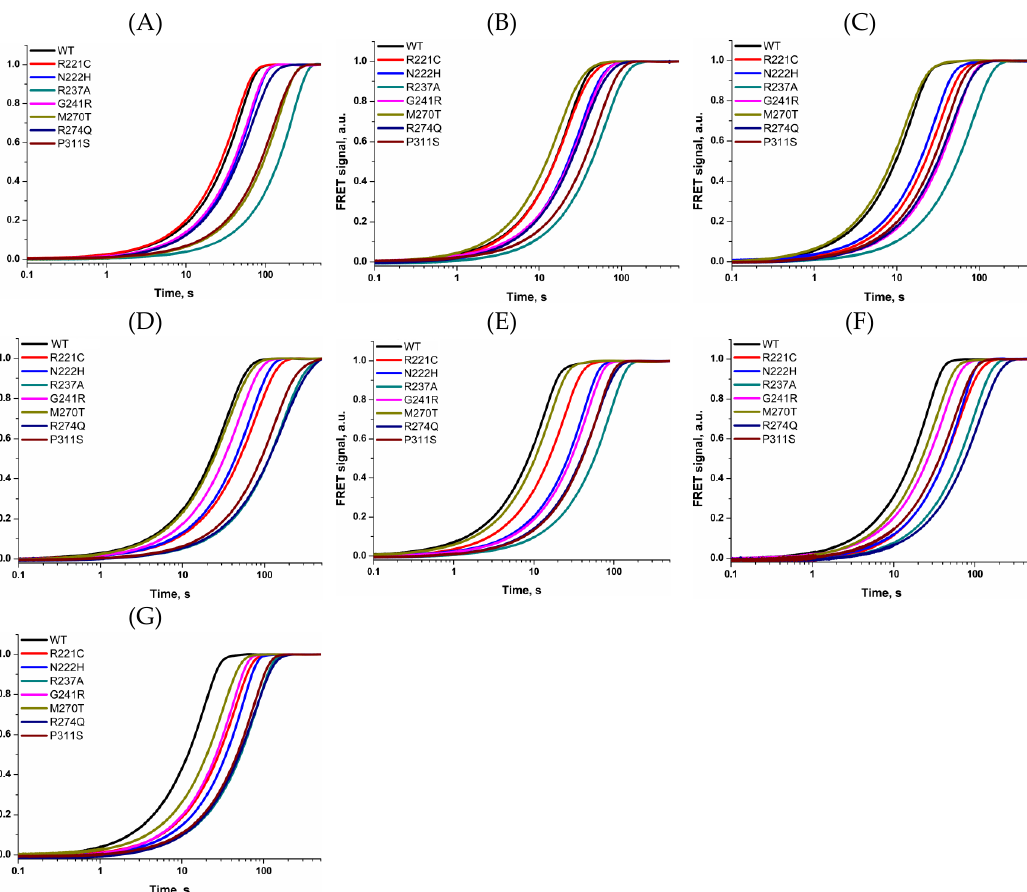
Figure 2. Interaction of WT APE1 or its SNP variants with the FRET ‐ labeled substrate. The FRET signal changes characterize the activity of WT APE1 and SNP variants without any effectors ( A ) or in the presence of AAG ( B ), OGG1 ( C ), UNG2 ( D ), Pol β ( E ), PCNA ( F ), or XRCC1 ( G ).